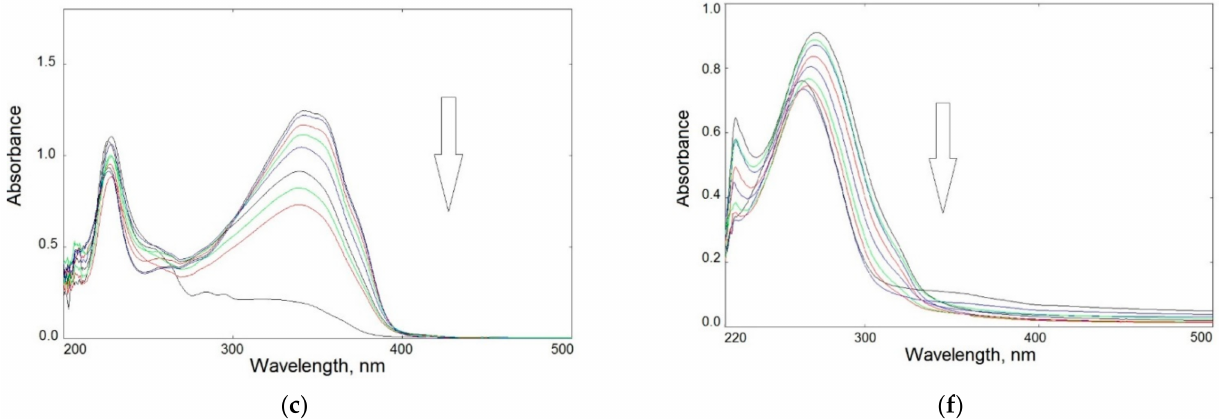
Figure 4. Changes in UV–Vis spectra of UV-irradiated samples in solution: left panel—BIm ( a ), BOx ( b ), and BTh ( c ) in methanol up to 60 min; right panel—CS-BIm ( d ), CS-BOx ( e ), and CS-BTh ( f ) in acetic acid solution up to 120 min (the arrows show the direction of absorbance